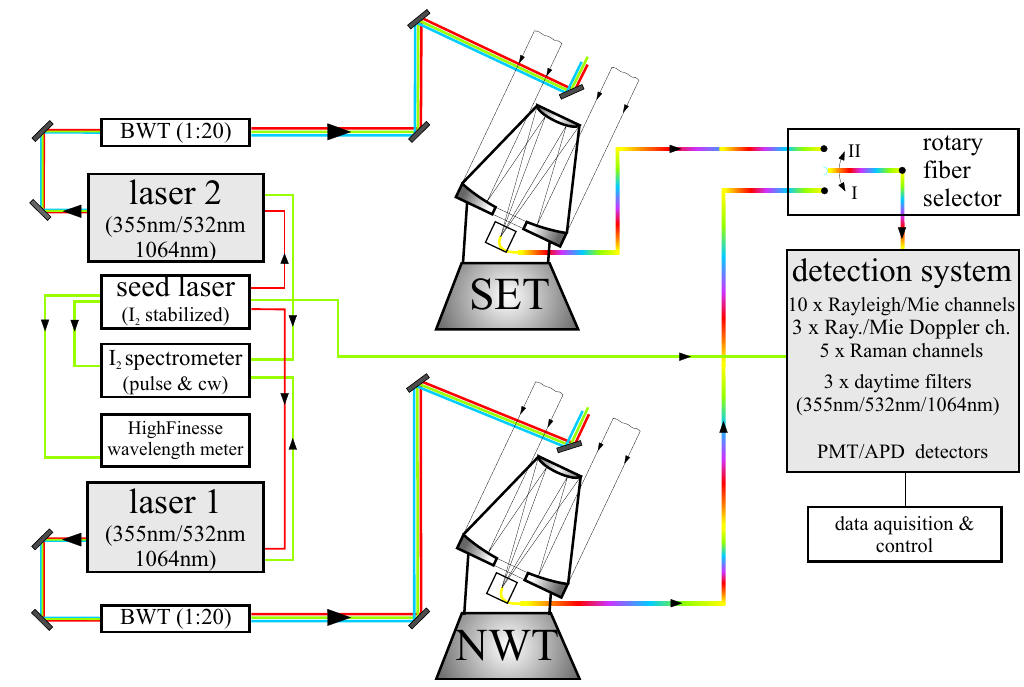
Fig. 3. Overview of the ALOMAR RMR lidar. Two pulsed power lasers (laser 1,2) are seeded with infrared light ( λ ∼ 1064nm) by one cw-laser stabilized to iodine absorption line 1109 ( λ ∼ 532nm). The optical connection between different components is indicated by red, green, and blue lines to indicate the wavelength of the light, 1064nm, 532nm, 355nm, respectively. The outgoing laser pulses are expanded to a diameter of d =20cm through beam widening telescopes (BWT) and guided to the optical axis of two tiltable telescopes ( d =1.8m). The light collected by the telescopes is guided through fibers ( d =1.5mm) to the detection